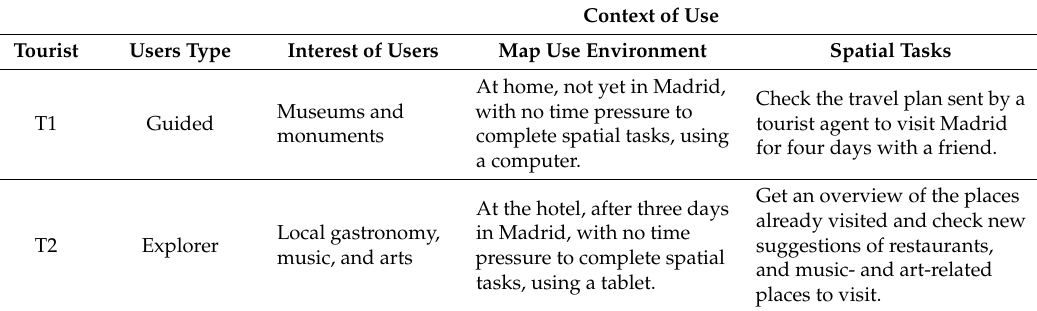
Table 2. User type and context of use for tourists T1 and